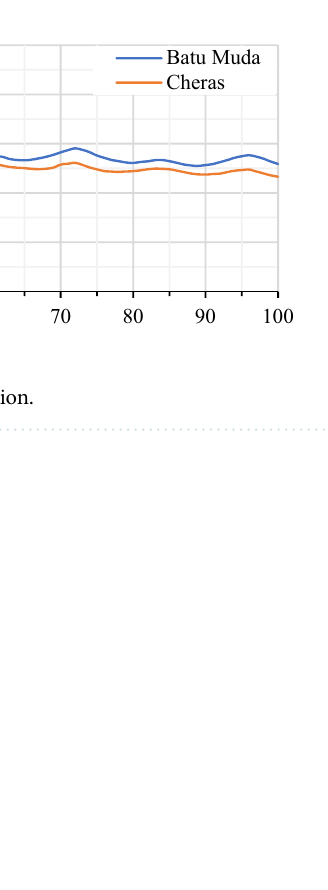
Table 2. Evaluation of EEMD-LSTM at different time lags for Cheras and Batu Muda datasets. Significant values are in bold.